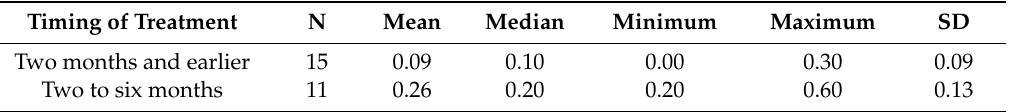
Table 7. LogMAR values of final BCVA in patients with a total resolution of SRF for the subgroups of patients according to the time point of the initiation of